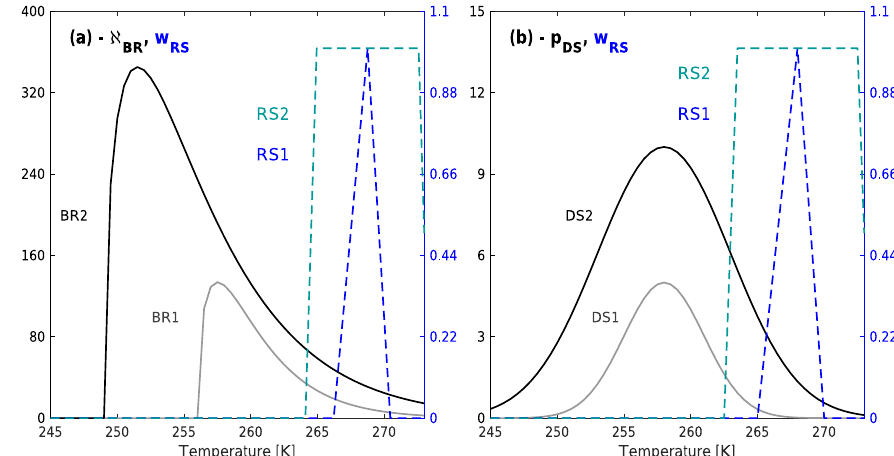
Figure 2. Fragment numbers, weightings, and probabilities from the secondary ice production parameterizations. In panel (a) , we show ℵ BR from both ice–ice collisional breakup simulations (BR1 and BR2) as well as the triangular and uniform w RS (T ) . In panel (b) , we show p DS from both droplet shattering simulations (DS1 and DS2) and w RS once again. The overlapping temperature regions of these are particularly important to understand any feedback between the